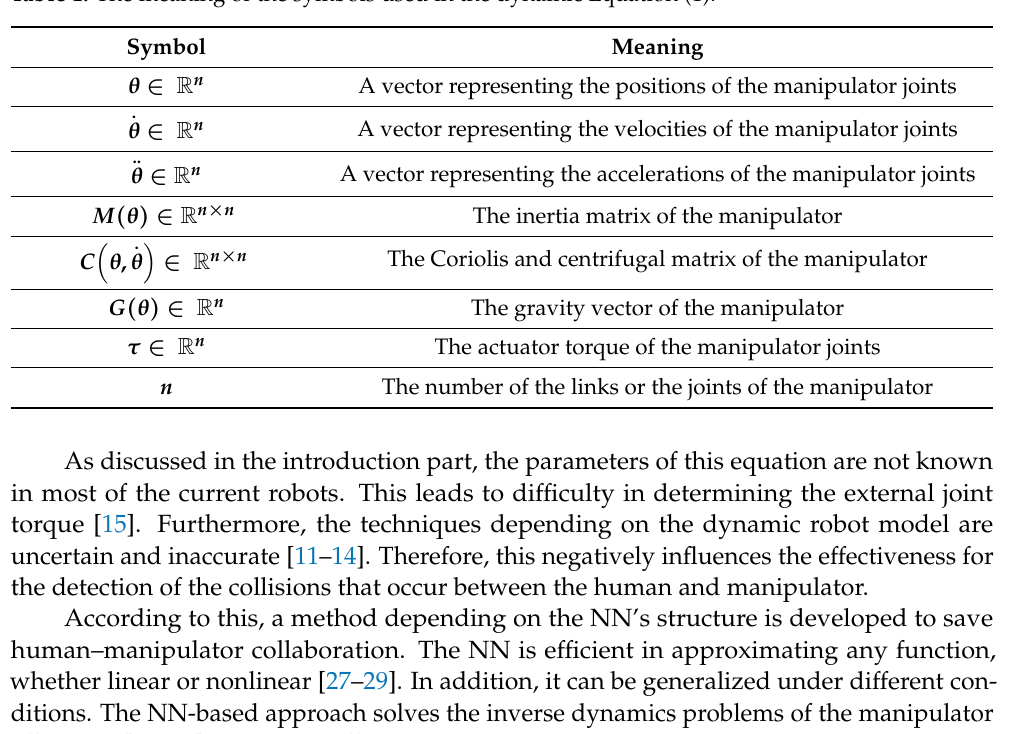
Table 1. The meaning of the symbols used in the dynamic Equation